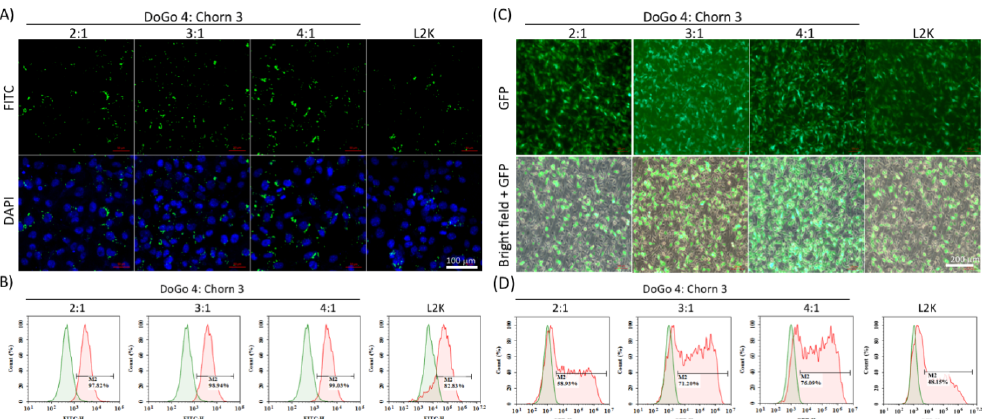
Figure 3. Cellular uptake of nucleic acid complexed to DoCh LNP composed of different ratio of DoGo4 and Chorn3. ( A ) Confocal images of B16F10 cells treated with FITC ‐ siRNA/DoCh LNP complexes; ( B ) Quantification of B16F10 cellular uptake of FITC ‐ siRNA/DoCh LNP complexes by flow cytometry; ( C ) Fluorescence images of B16F10 cells treated with pcDNA ‐ eGFP/DoCh LNP complexes; ( D ) Quantification of GFP expression of B16F10 cells treated with pcDNA ‐ eGFP/DoCh LNP complexes by flow cytometry.